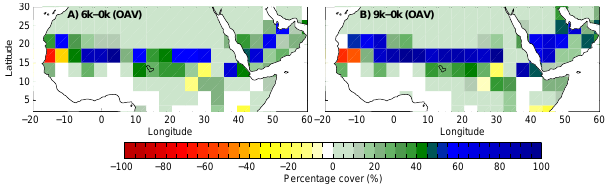
Figure 2. Change in total (i.e. all PFTs) percent vegetation cover for (a) the mid-Holocene (6kaBP) and (b) the early Holocene (9kaBP) experiment relative to the pre-industrial period